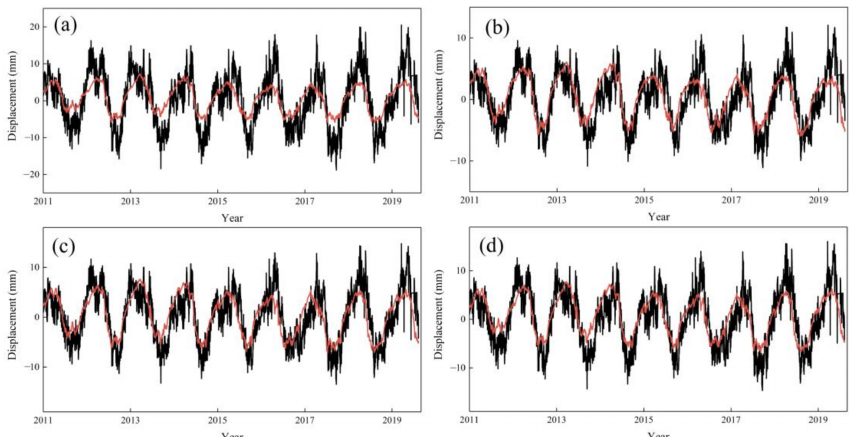
Figure 11. Comparison of CME with HYDL time series provided by EOST at SCML ( a ), SCXC ( b ), YNLJ ( c ), and YNYS ( d ) stations. The black line represents the CME and the red line represents the EOST_HYDL time series.